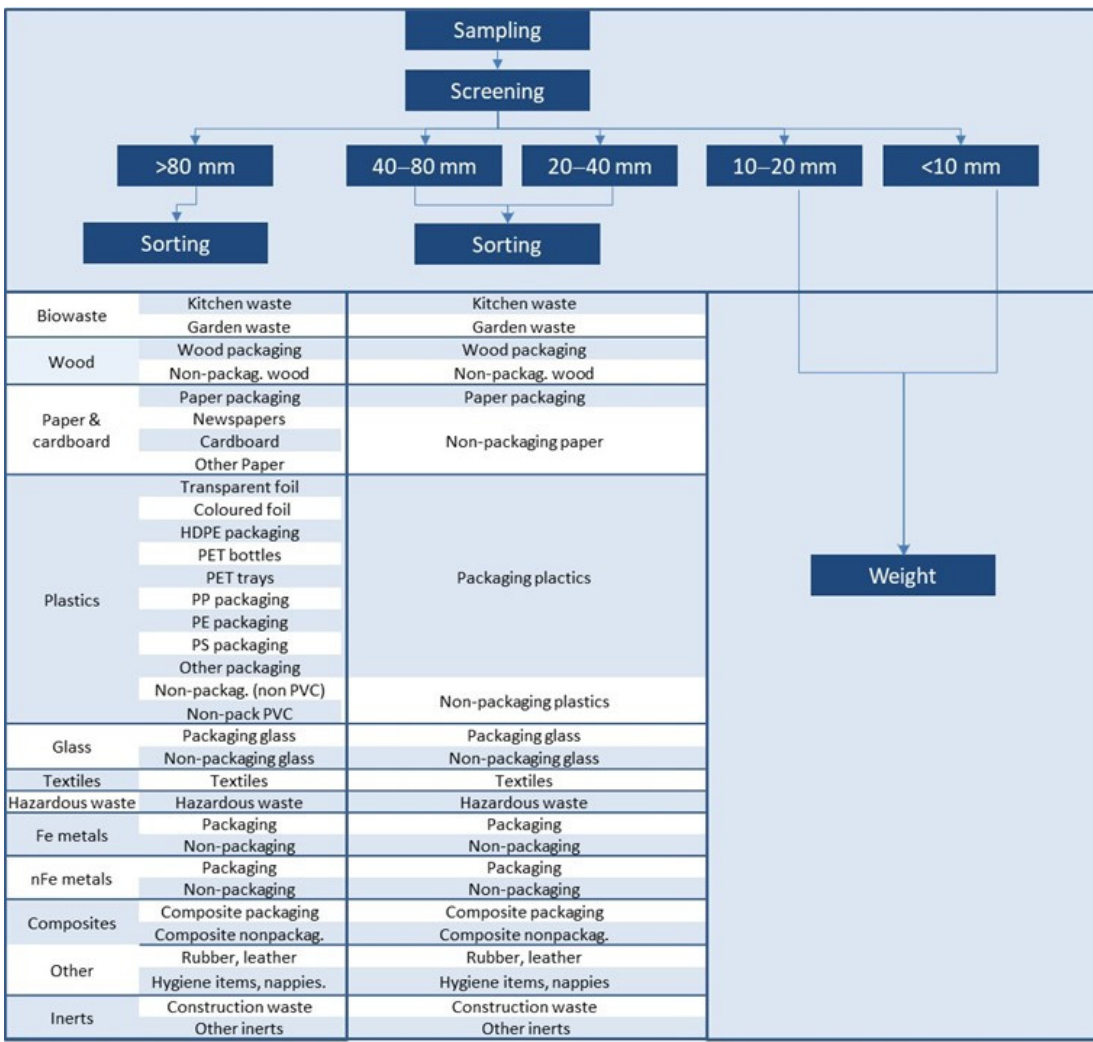
Figure 1. Sampling schedule according to modified SWA Tool methodology.